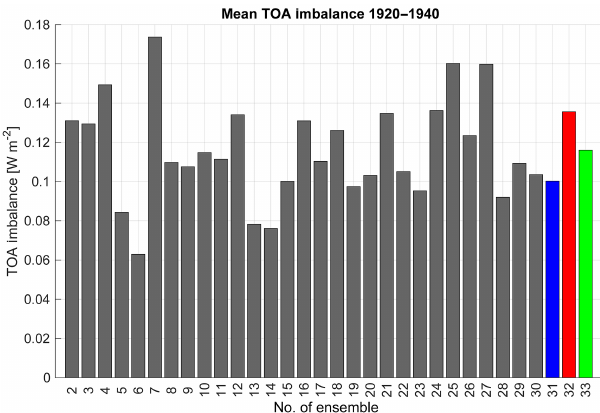
Figure 3. Global mean of top-of-model energy imbalance from 1920 to 1940 for CESM-LE members 2–30 and the three new mem- bers (31–33). Note that members 31 and 33 have been subjected to lossy